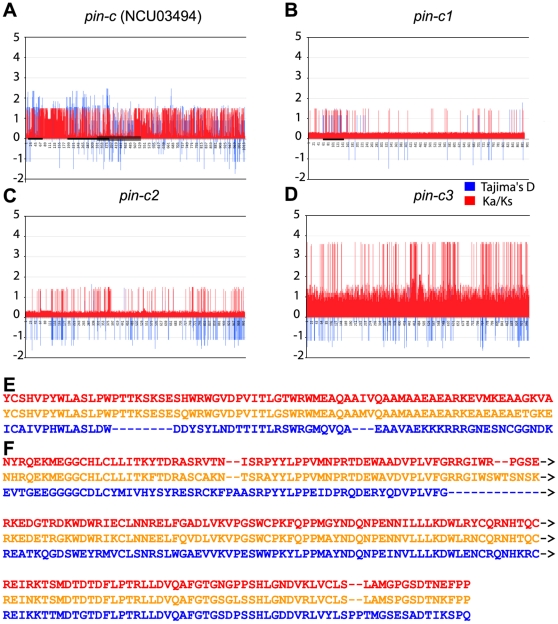
Measure of Ka/Ks ratios and Tajima's D on the coding region of pin-c (NCU03494) show evidence for balancing selection between allele classes.Ka/Ks ratios (ω, ratio of nonsynonymous (Ka) to synonymous (Ks) nucleotide substitution rates; red) were calculated for each codon for all pin-c alleles and significant positive selection between positions 77–746 (p = 0.001) by likelihood ratio test was detected. These positions include the HET domain (codons 335–533) of pin-c (NCU03494)(large bar on x-axis). Tajima's D calculated for each codon for all pin-c alleles shows significant balancing selection (P<0.1) at positions 8–78 and 190–390 (smaller bars on x-axis; see E and F). Evaluation of Ka/Ks (red) and Tajima's D (blue) within a pin-c allele class shows variable selection: B) A region from codon 60 to 150 shows evidence of balancing selection in pin-c1 alleles (shown as a bar on the x axis) C) pin-c2 D) pin-c3. pin-c3 alleles show an extremely high ω with three very polymorphic regions (codons 448–491, 569–639 and 738–781). E and F) Amino acid alignments of putative allelic specificity regions of pin-c (the locations of these regions are indicated by bars on the x-axis of panel A).